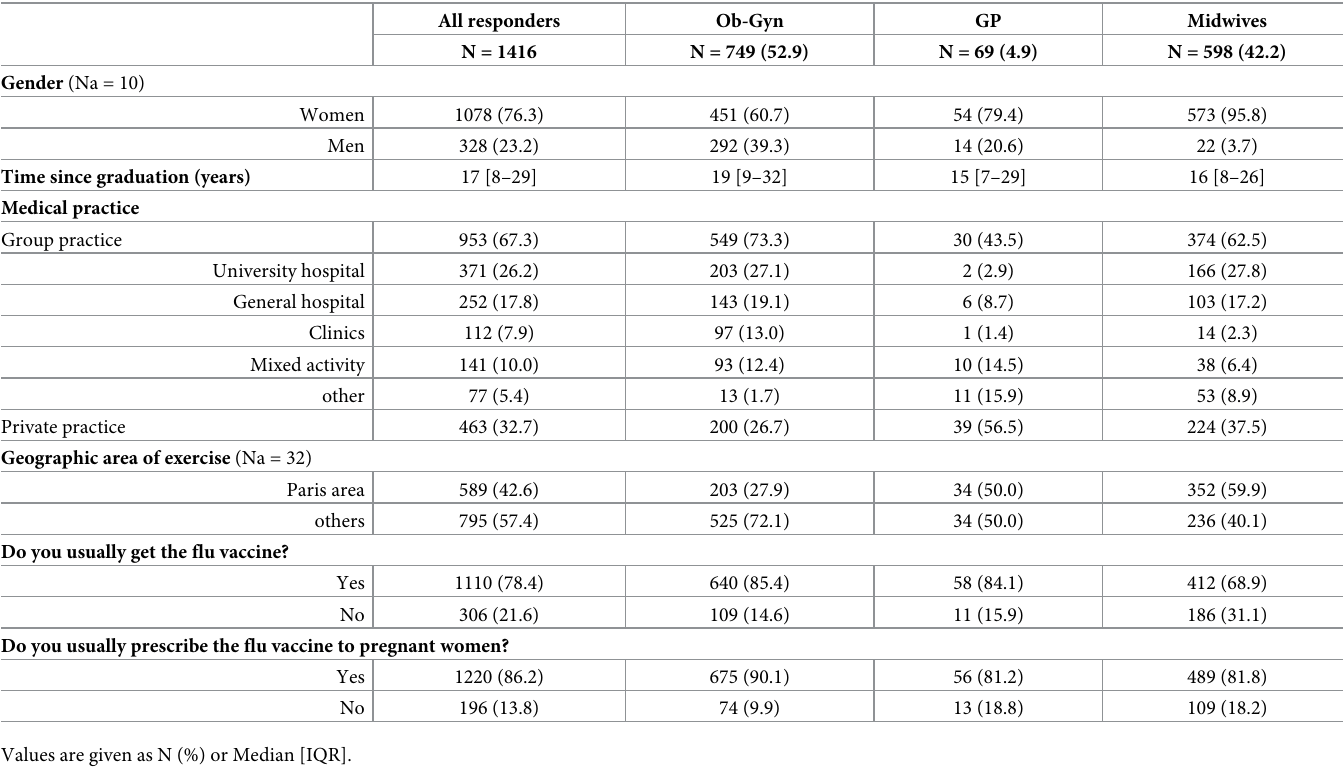
Table 1. Prenatal caregivers’ demographic information and flu vaccination habits for themselves and their